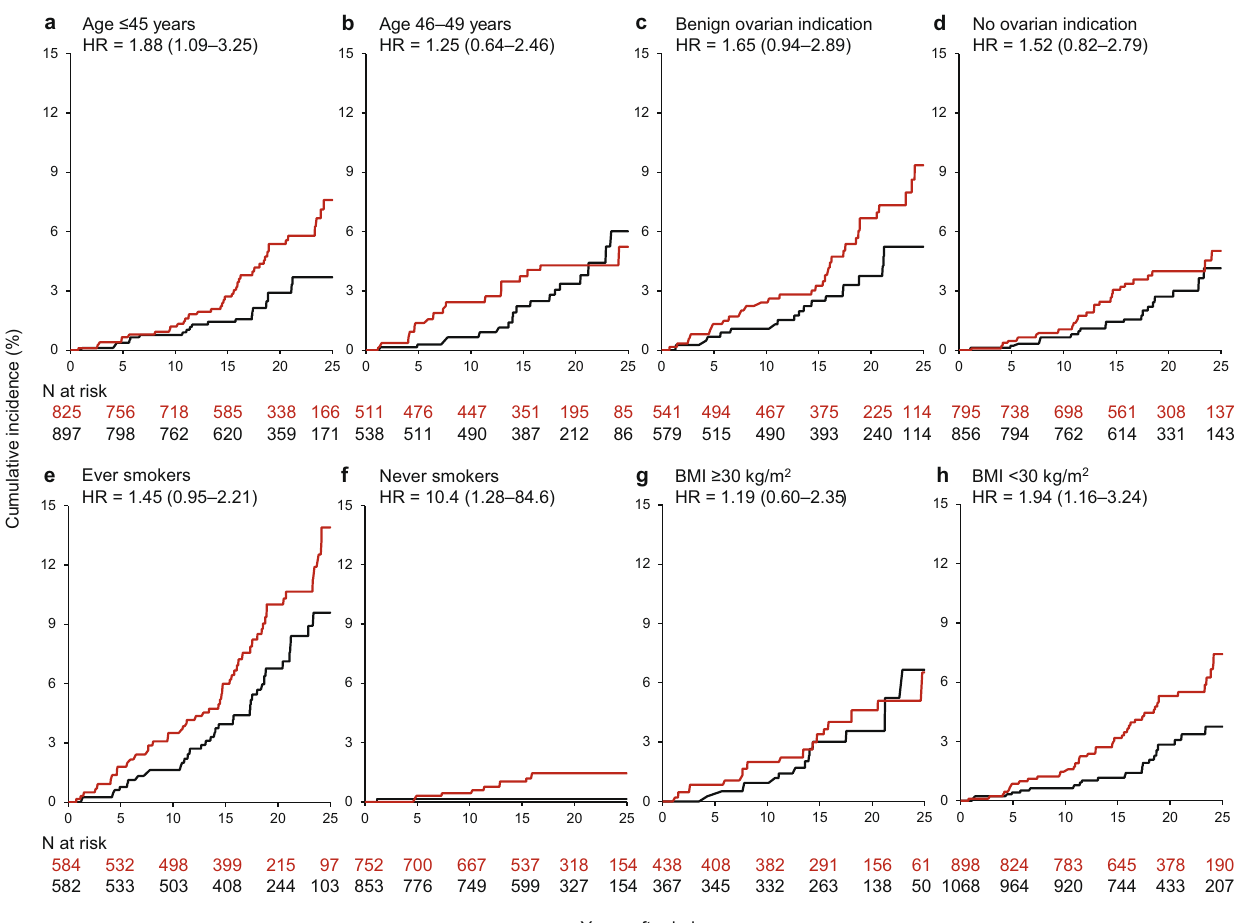
Fig. 3 Cumulative incidence curves for all chronic obstructive pulmonary disease in women who underwent bilateral oophorectomy compared with referent women. a , b Strata by age at oophorectomy; c , d strata by surgical indication; e , f strata by smoking status; g , h strata by body mass index at index date. The curves were weighted using inverse probability weights derived from a logistic regression model including 16 chronic conditions present at index, years of education, quartiles of household income, race, body mass index, cigarette smoking, and age and calendar year at index date (details provided in text). The interactions were not signi fi cant by age at oophorectomy, surgical indication, smoking status, or by body mass index. BMI body mass index, HR hazard